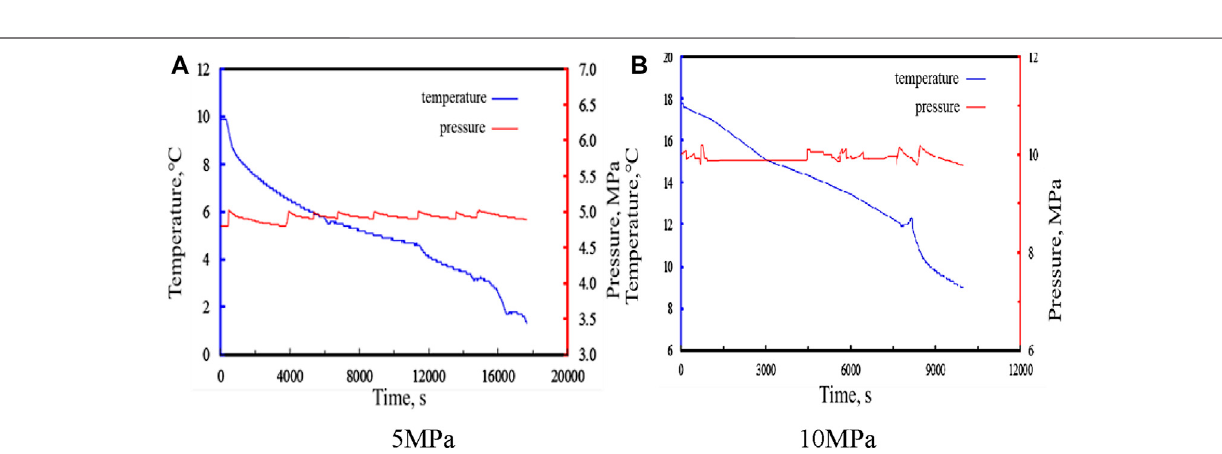
Frontiers in Energy Research |